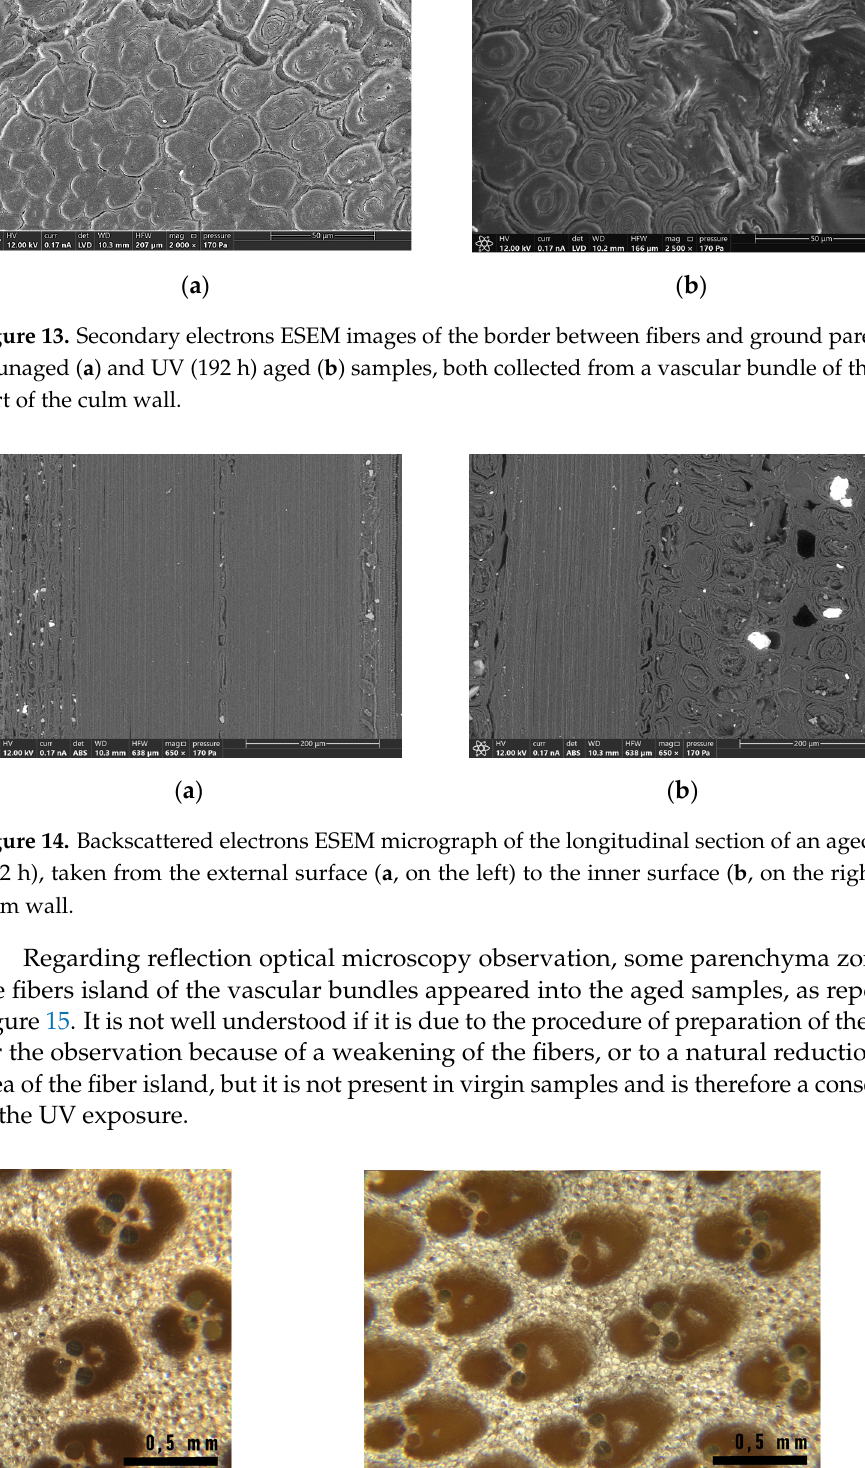
Figure 15. Optical microscopy images showing holes in the fiber island of the vascular bundles of the middle part of the culm wall for natural ( a , on the left) and treated ( b , on the right) samples after 192 hours of exposure to UV irradiation.